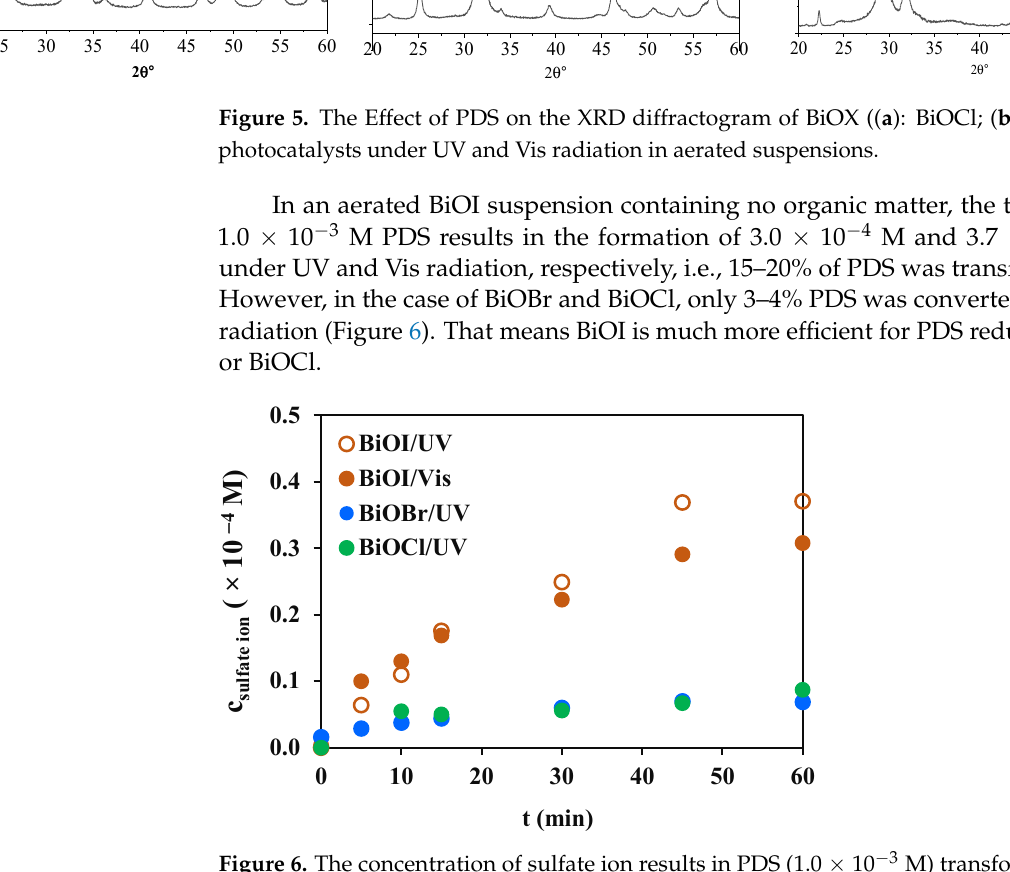
Figure 6. The concentration of sulfate ion results in PDS (1.0 × 10 − 3 M) transformation in UV and Vis irradiated, aerated BiOX suspensions without organic substances.